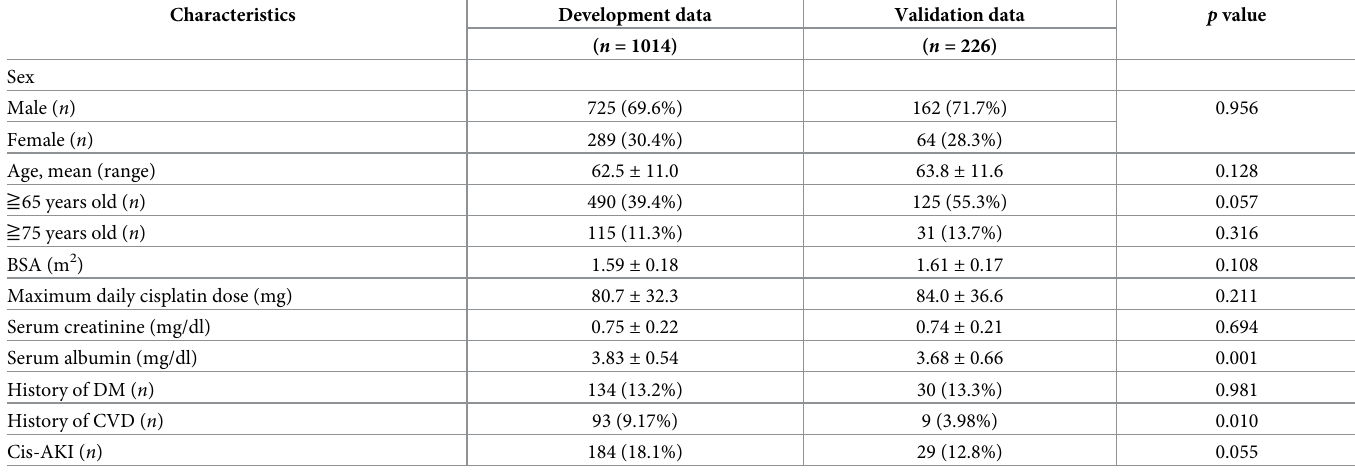
Table 1. Baseline